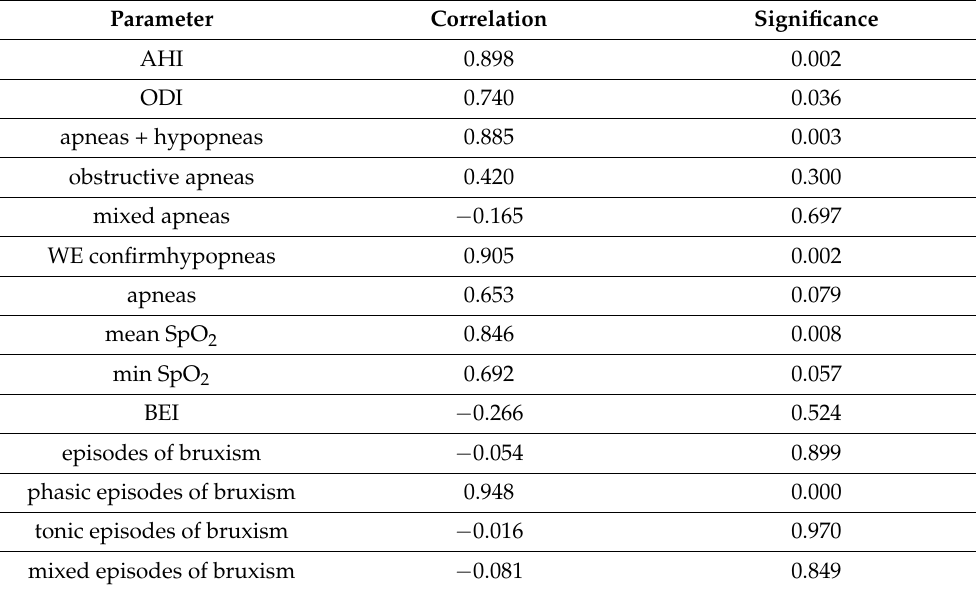
Table 4. Correlations of the dependent samples with and without an MAD (N =